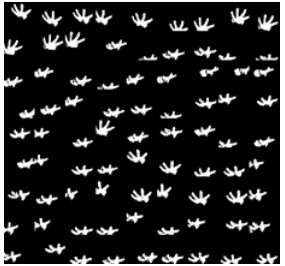
Figure 4. A sample tiled pattern. Each row presents a sub-gesture. There is a zero padding between each two adjacent